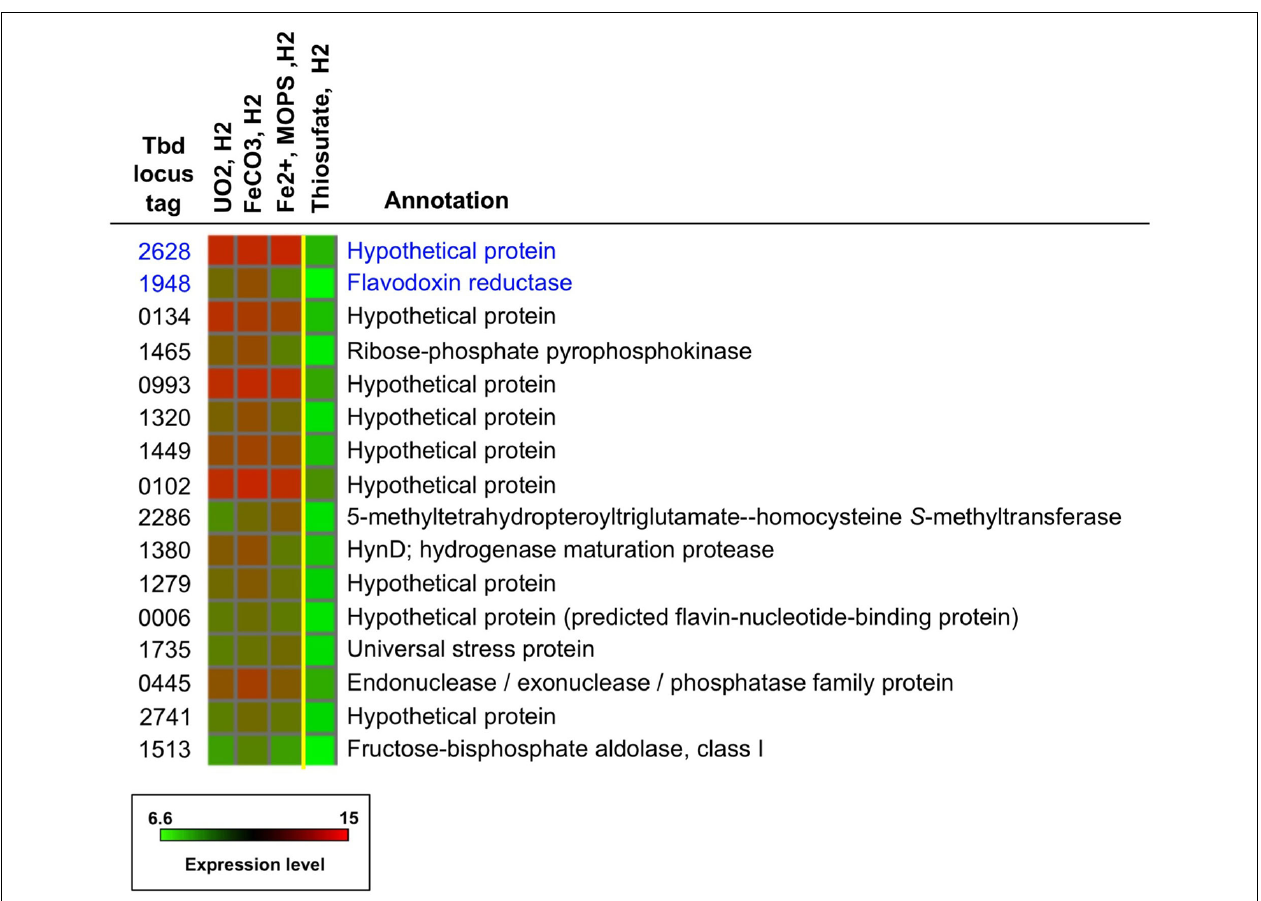
FIGURE 5 | Expression profiles and annotations for a group of 16 of the most highly expressed genes under under nitrate-dependent UO 2 -, FeCO 3 -, and Fe 2 + -oxidizing conditions (GroupsVI,V, and II, respectively; see text). The two genes highlighted in blue were targeted for mutation studies.The intensity color scale is the same as for Figure 2